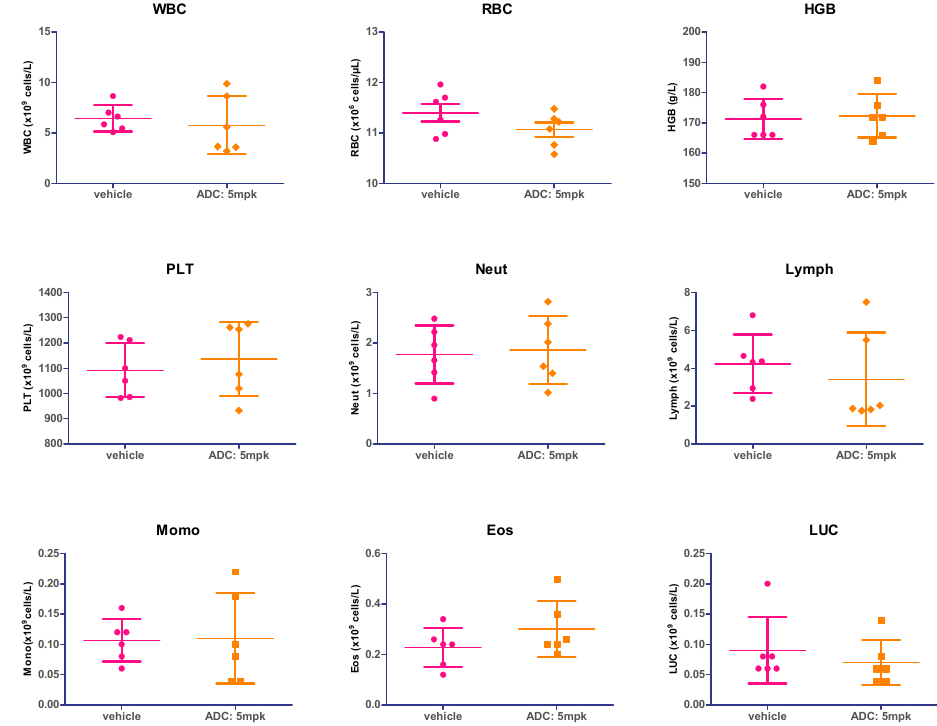
Figure 9. Hematological analysis of acid-sensitive ADC (mil40-6). WBC: white blood cells; RBC: red blood cells; HGB: hemoglobin; PLT: platelets; Neuts: neutrophils; Lymph: lymphocytes; Mono: monocyte; Eos: eosinophils; LUC: large unstained cell. Results are shown as mean ± SD, n = 6/group.